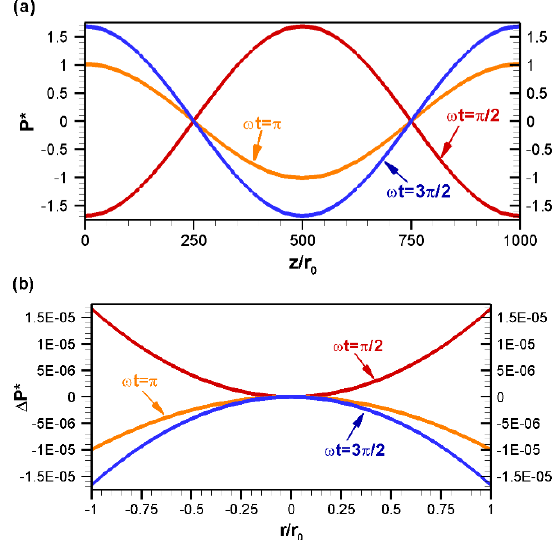
* P Pr u  , at various nondimensional times: ( a ) Figure 7. Distribution of gauge pressure, Figure7. Distributionofgaugepressure, P ∗ = Pr 0 / µ u HS , atvariousnondimensionaltimes: ( a )Variation 0 HS 0 r r  and ( b ) along the radial direction at 500 z r  , along the axial direction at r / r 0 = 0 and ( b ) along the radial direction at z / r 0 = 500, where ∆ P ∗ = Variation along the axial direction at 0 0 P ∗ − P ∗ ( r / r 0 = 0 ) . All other conditions are same as those in Figure * * *( / 0) P P P r r     . All other conditions are same as those in Figure 3. where 0